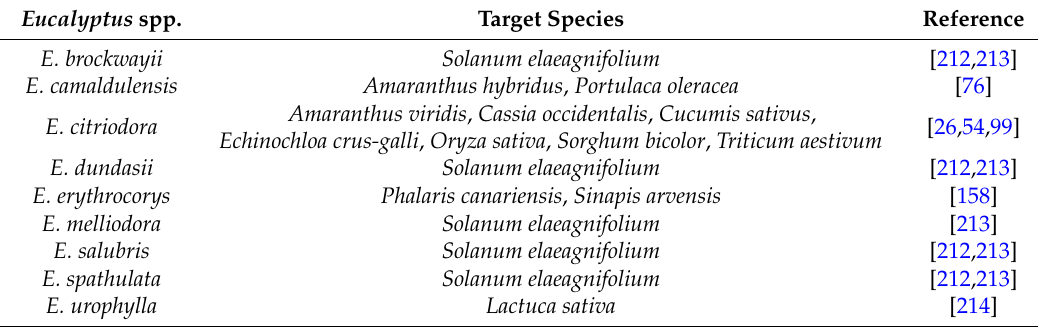
Table 6. Eucalyptus spp. essential oils with herbicidal